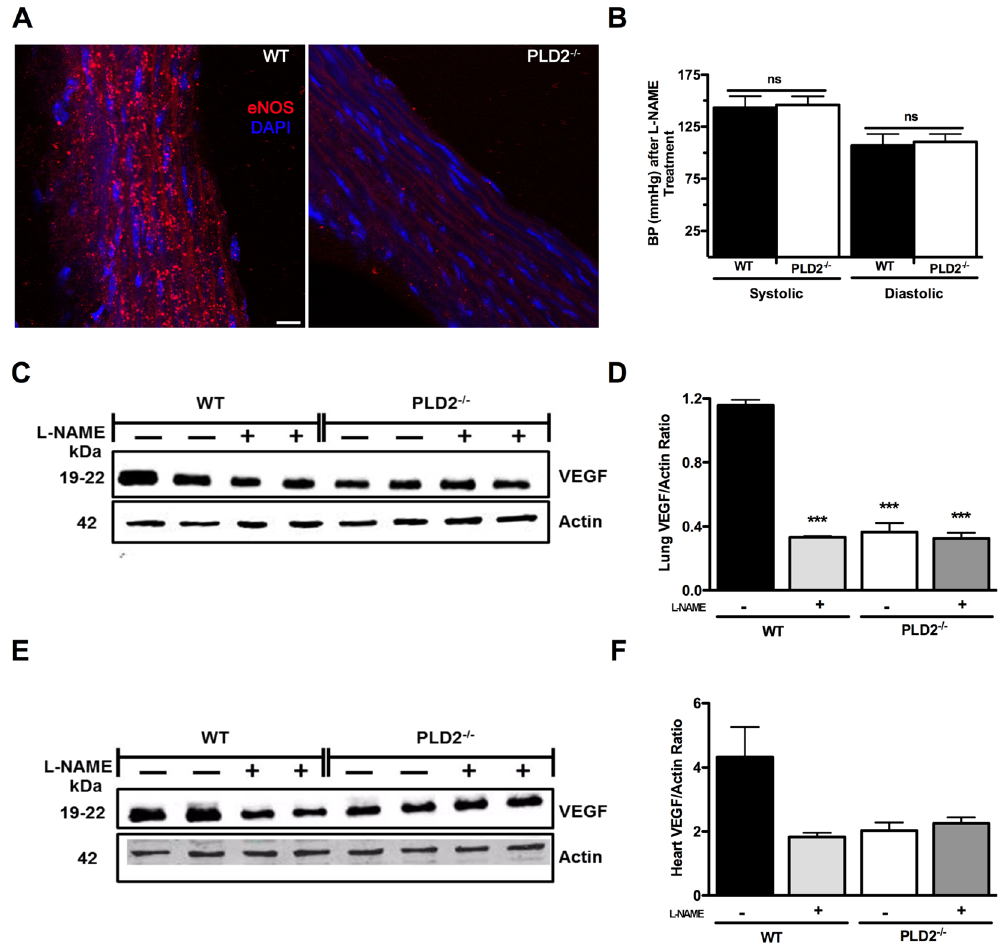
Figure 3. Decreased BP in PLD2 − / − mice results from reduced levels of eNOS protein. ( A ) Immunofluorescent staining of eNOS in sections of aortas from WT and PLD2 − / − mice. Bar, 7.5 μ M. Representative image from 4 mice of each genotype. ( B ) Systolic and diastolic blood pressure following treatment with L-NAME for one week (n = 4). ( C – F ) Measurements of VEGF protein levels by western blotting of PLD2 − / − and WT mice lungs ( C , D ) and heart ( E , F ) were normalized to actin expression levels (n = 4 mice of each genotype). A representative blot is shown. The regions of the Western blots containing the VEGF and actin immunoreactive bands were scanned and the relative abundance of the individual samples quantified using an Odyssey CLx imaging system. Mean ± SEM; *** p ≤ 0.001; B: Student’s t-test; D, F: One-way ANOVA with Bonferroni’s Multiple Comparison